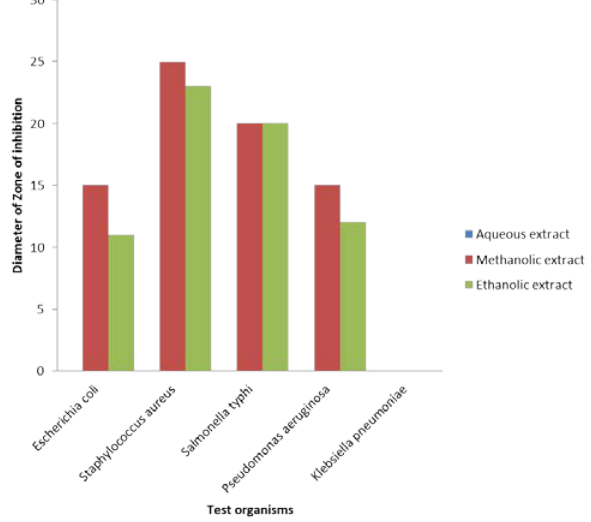
Fig. 2. Antimicrobial activity of ethanolic, methanolic and aqueous leaf extracts of Senna alata on test